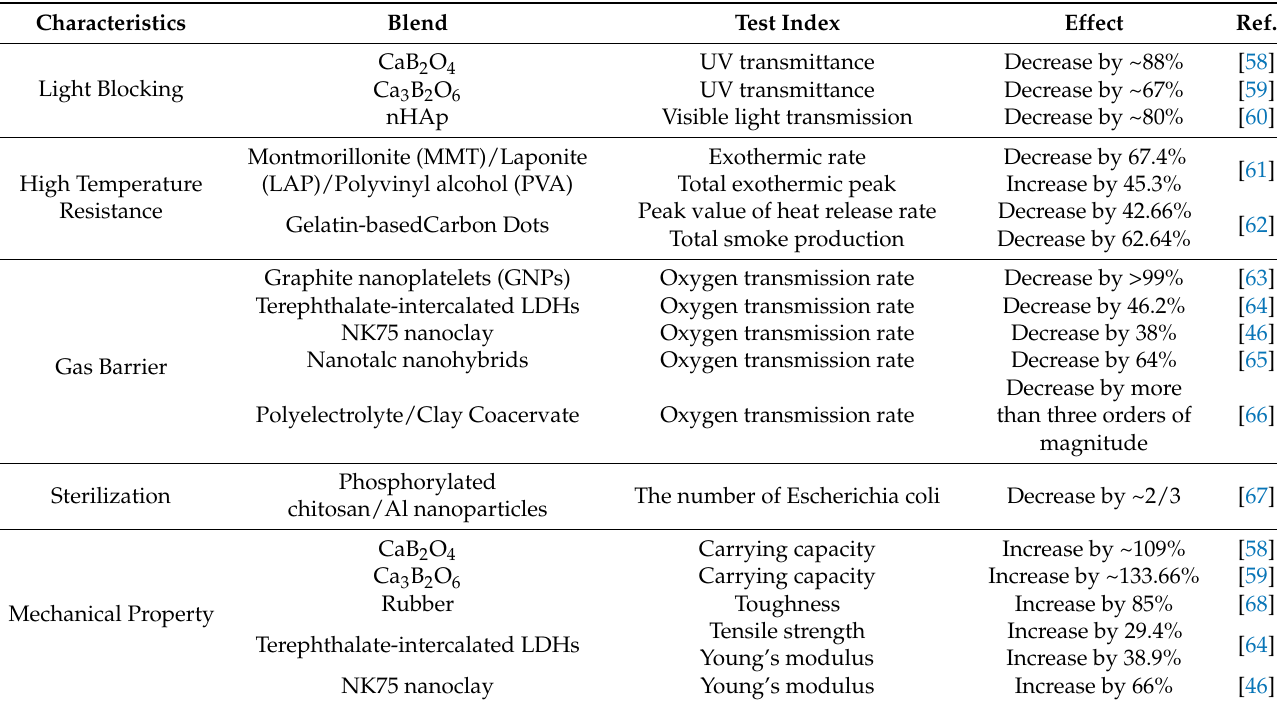
Table 1. Multifunctional PET by adding raw